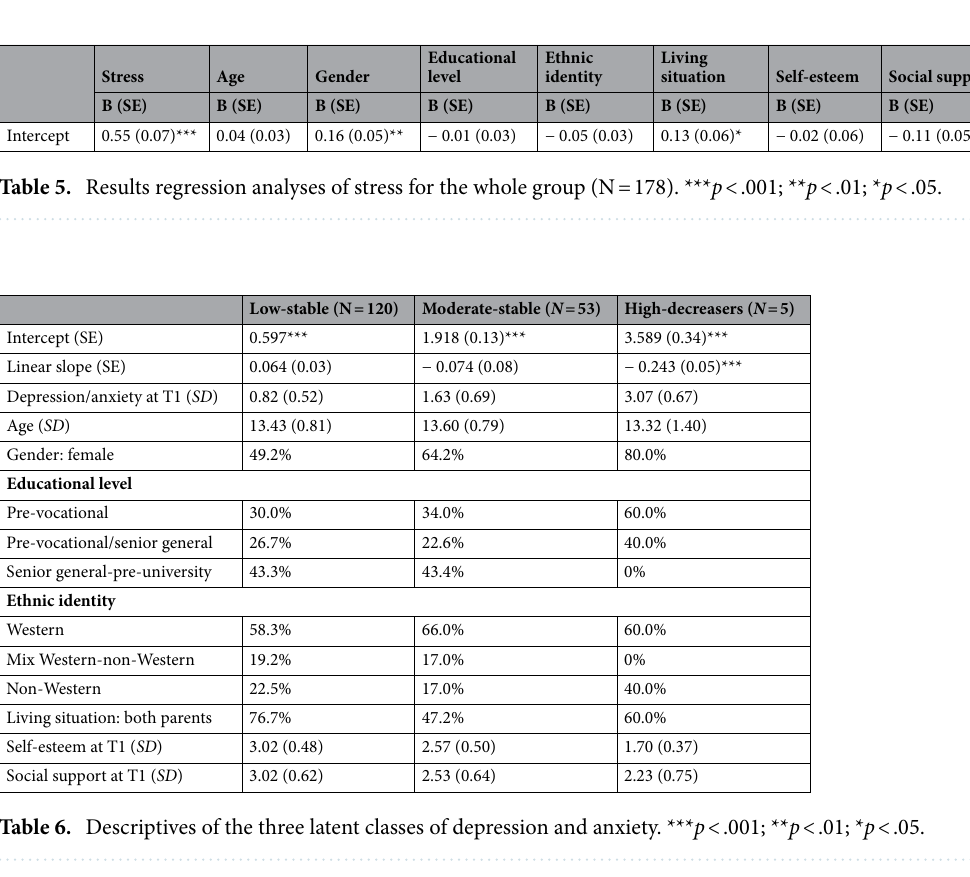
Educational Ethnic Living level identity situation Self-esteem Social support